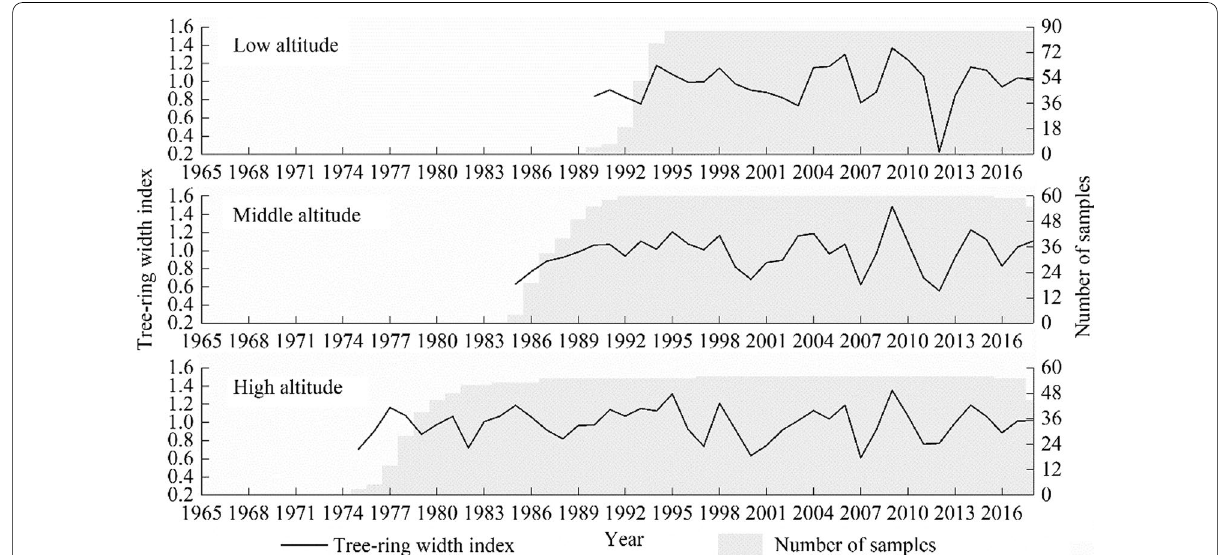
Fig. 2 Tree-ring width standard chronologies (solid black line) with their sample depths (grey-shaded area) along the altitudinal gradient